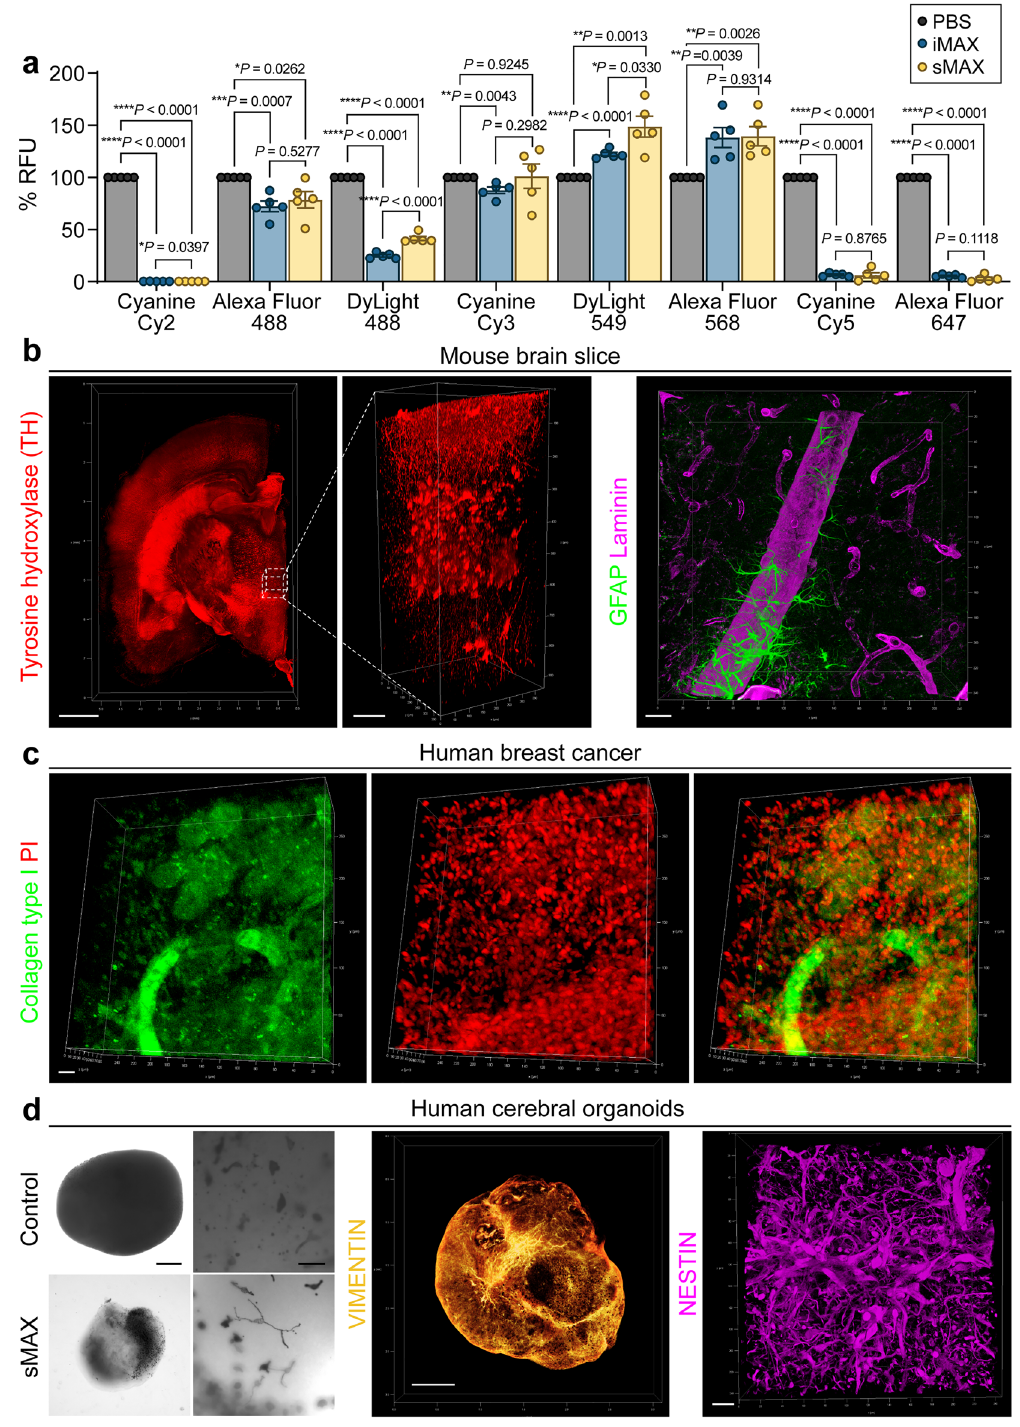
Figure 5. Immunofluorescence 3D imaging with sMAX media. ( a ) Quantification of fluorescence signal changes by the mix with MAX media. Fluorescence-labeled antibody was diluted 10 times with PBS, iMAX, and sMAX, and the fluorescence signal intensities were measured with fluorometer 18–24 h later. ( b ) Reconstituted 3D image of 2-mm brain slice. Samples is stained with tyrosine hydroxylase (TH), and then immersed in sMAX ( b , left). Scale bars, 1 mm for whole image and 100 μm for ROIs. Visualization of blood vessels (stained with Laminin) and surrounding glial cells (stained with glial fibrillary acidic protein, GFAP) using immunostaining ( b , right). Scale bar, 20 μm. ( c ) Visualization of collagen type I (green) in the breast cancer biopsy specimen. Nuclei are counter-stained with propidium iodide (red). Scale bar, 20 μm ( d ) Clearing of human cerebral organoids in sMAX media. Bright-field images of cerebral organoids exhibiting neuromelanins ( d , left). Images were taken with an EVOS microscope (Thermo Fisher Scientific). Scale bar, 500 μm for whole cerebral organoid images and 50 μm for high-magnified images. 3D whole-mount immunostaining of organoids labeled for Vimentin ( d , middle). Scale bar, 500 μm. 3D highly magnified image showing cellular arrangements stained with NESTIN ( d , right). Scale bar, 20 μm. All fluorescent images were acquired using a TCS SP8 confocal laser- scanning microscope and processed with Las X